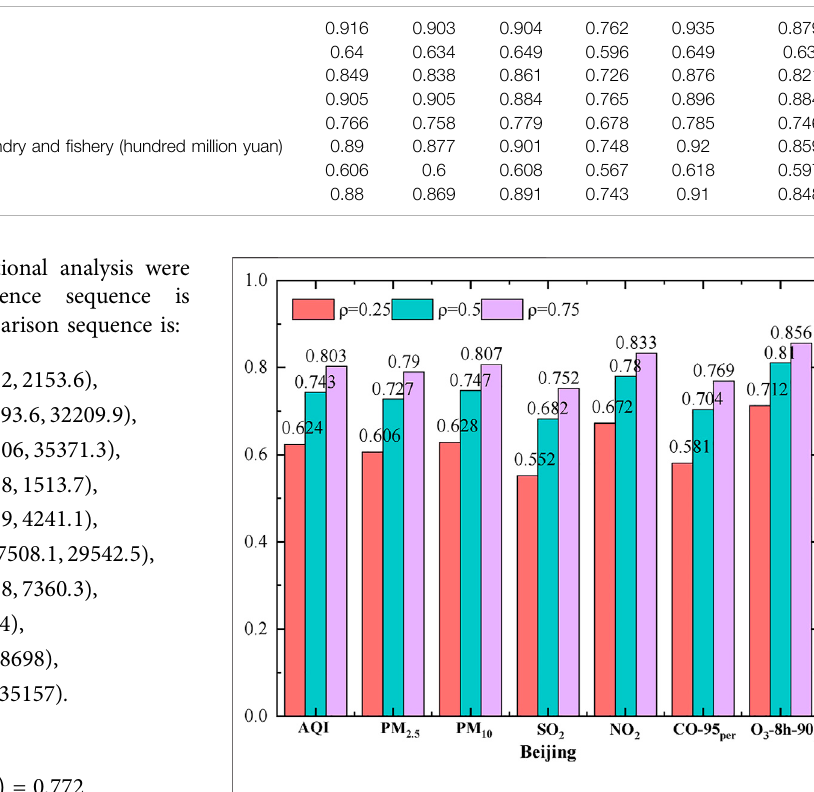
FIGURE 1 | Grey average correlation coef fi cient of air index under different resolution coef fi cients in